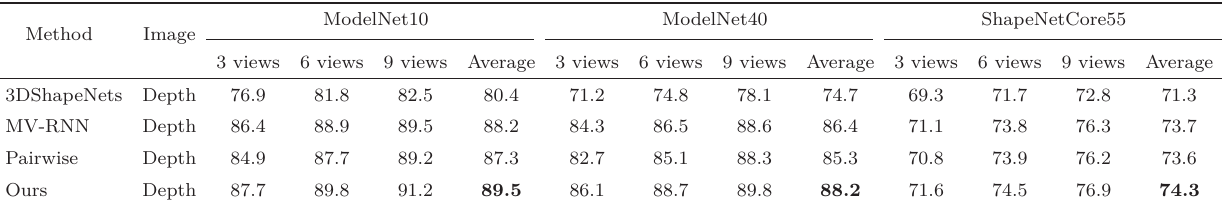
Table 3 Recognition accuracy for four methods and three datasets